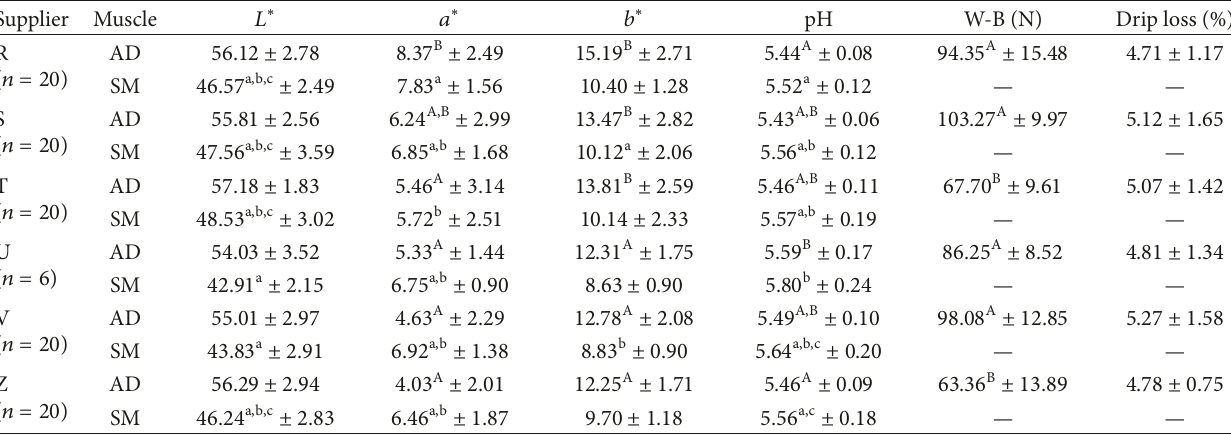
Table 1: Physical properties of m. adductor (AD) and m. semimembranosus (SM) (mean ± SD). The colour of m. adductor (AD) and m. semimembranosus(SM) wasmeasuredbytheCIELABsystem,thepHvaluewasdetected72hoursp.m.bypHmeterwithaDoublePoreneedle probe, the Warner-Bratzler test (W-B) was performed on an INSTRON 5544 instrument, and drip loss was evaluated using polyethylene bag and filter paper.